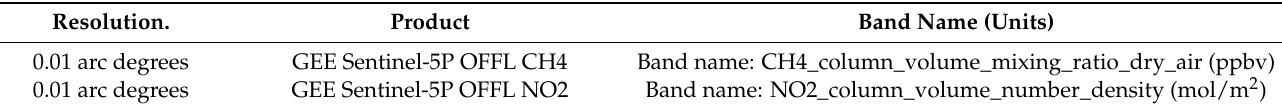
Table 2. TROPOMI sensor Level 3 products from Google Earth Engine (GEE) Cloud Data Archive used in processing the Level 3 GEE products. Refer to Table S1 for information about the underlying L2 TROPOMI products, resolution, and algorithm versions